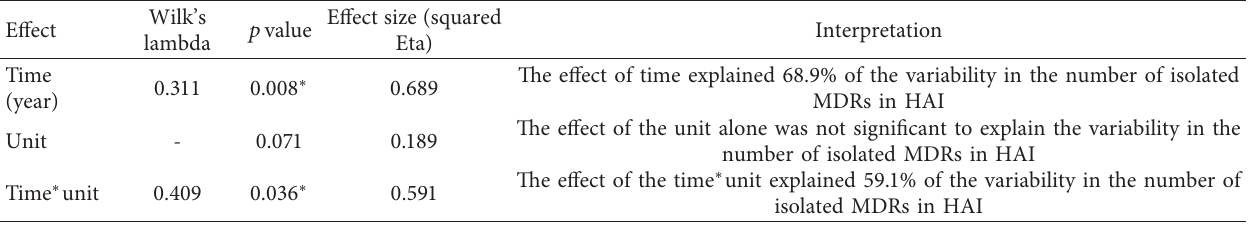
Table 2: Effect of time and unit on the number of isolated multidrug-resistant organisms in hospital-acquired infections from 2015 to 2020. Effect